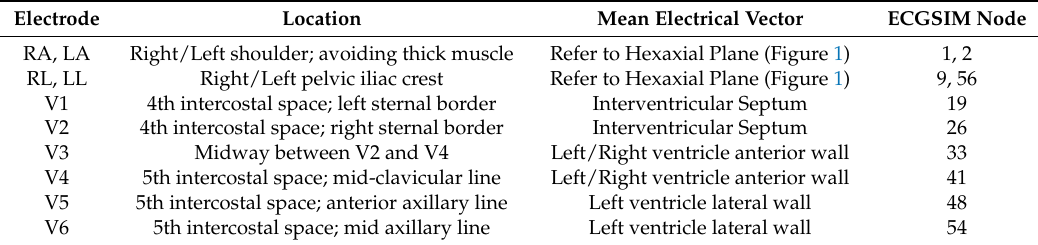
Table 1. Standardized location of electrodes used during 12-lead electrocardiograph (ECG) recording. Electrode